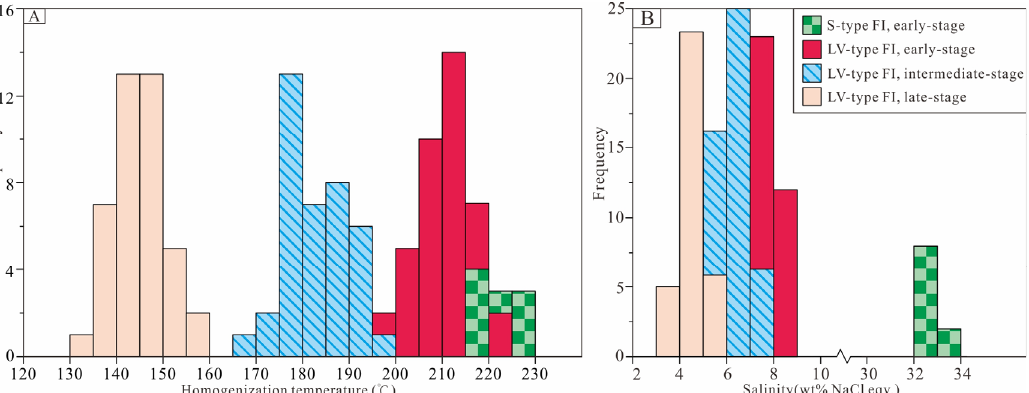
Figure 6. ( A ) Histograms of homogenization temperature and ( B ) salinity of FIs in quartz of different stages.